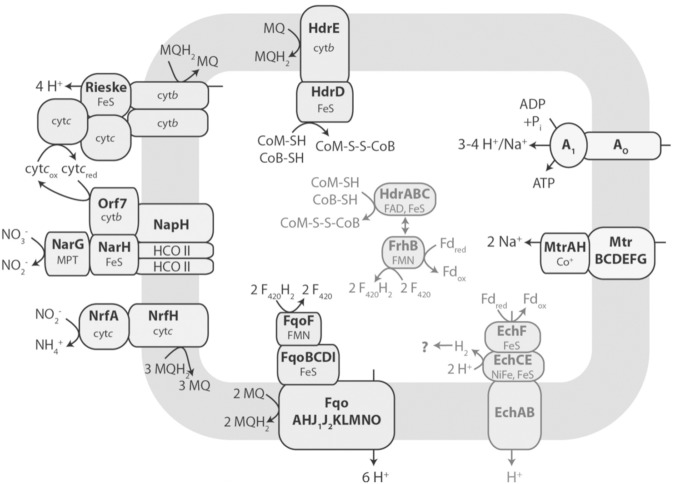
Metagenomics-based model of electron transport in reverse methanogenesis by Methanoperedens. Key: Fdred, reduced ferredoxin (Fdx2-); Fdox, oxidized ferredoxin (Fdx); Fqo, F420H2 dehydrogenase complex; MQ, menaquinone; MQH2, menaquinol; Hdr, heterodisulfide reductase; cyt b, cytochrome b; cytc, cytochrome c; Nar, nitrate reductase complex complex; Nrf, nitrite reductase; Ech, ferredoxin-dependent hydrogenase complex; FrhB, F420-binding subunit of F420-dependent hydrogenase; Mtr, methyltransferase complex; A1AO, ATP synthase; HCO II, heme copper oxidase subunit-like proteins; FMN, flavin mononucleotide; FAD, flavin adenine dinucleotide; MPT, molybdopterin; NiFe, nickel-iron center. Reproduced by permission (Arshad et al., 2015).